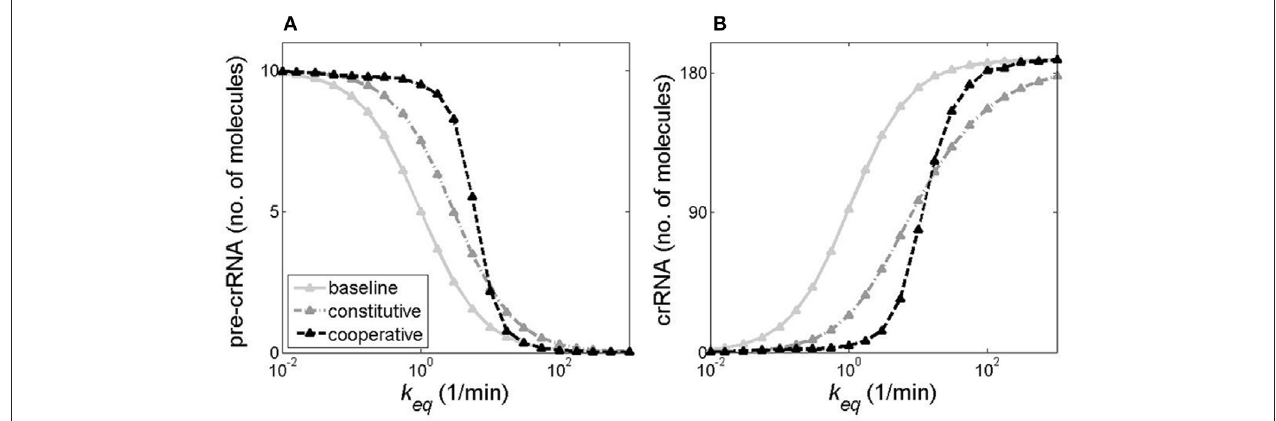
FIGURE 8 | Pre-crRNA and crRNA amounts early post-induction for different models of cas gene transcription regulation. The figure shows (A) pre-crRNA and (B) crRNA amounts 20min post-induction (i.e., 20min after introduction of the vector expressing cas genes), as a function of the maximal (equilibrium) value of the transcript processing rate k . CRISPR promoter transcription activity is kept constant ( ϕ = 10 1/min). The gray solid, the gray dash-dotted, and the black dashed curves correspond, respectively, to baseline, constitutive, and cooperative models of cas regulation.